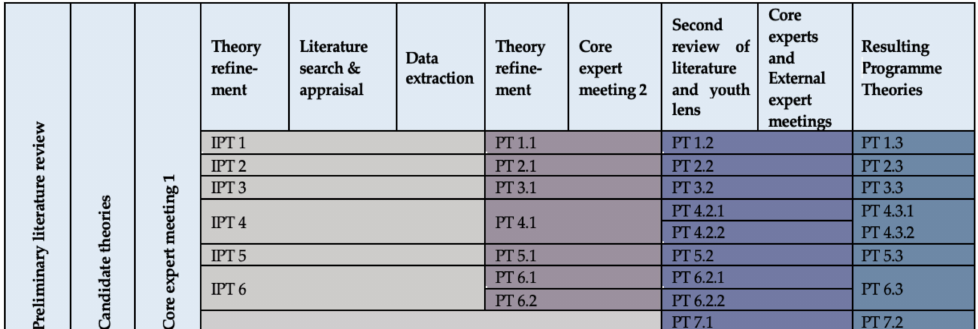
Figure 3. Timeline of the programme theory